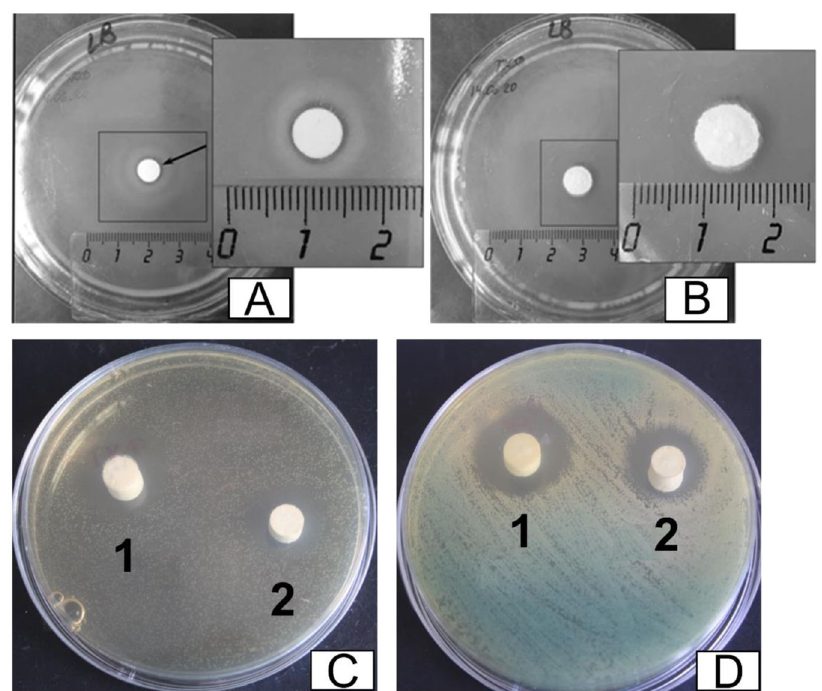
Fig. 7 The inhibition of growth of: E. Coli for A Zn-TCP cement and B TCP cement; C E.